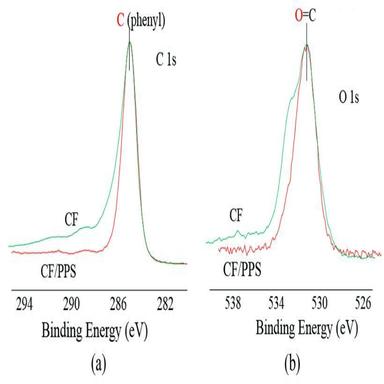
Overlapping spectra for CF and CF-PPS; (a) C 1s, and (b) O 1s.